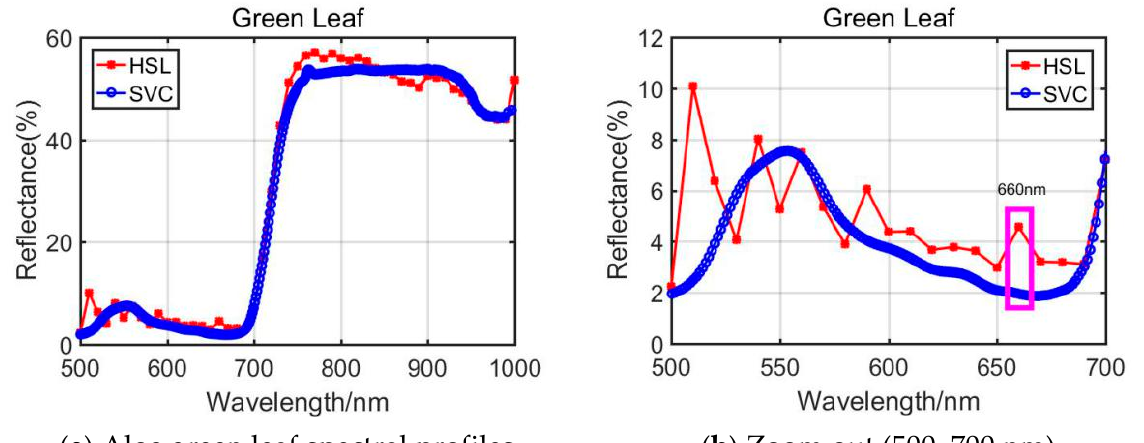
Figure 5. Aloe green leaf spectral profiles.